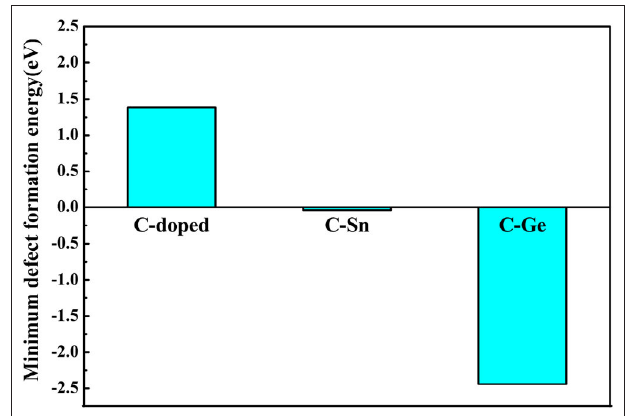
FIGURE 5 | The obtained minimum defect formation energies for monodoped and codoped GaN nanosheets.